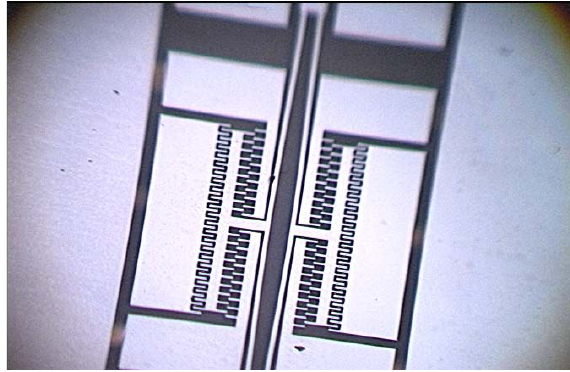
Figure 8. The deformation of the accelerometer with common DETF after packaging.